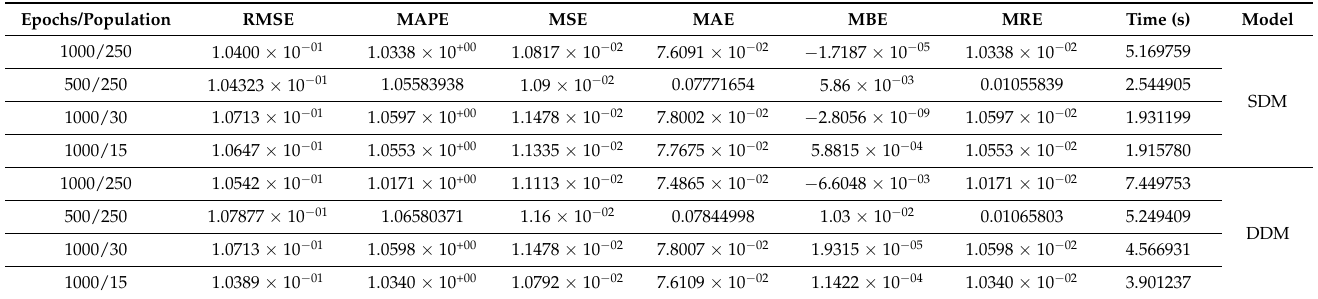
Table 27. Influence of the epochs and population on the statistical tests, Kyocera KC200GT photo- voltaic